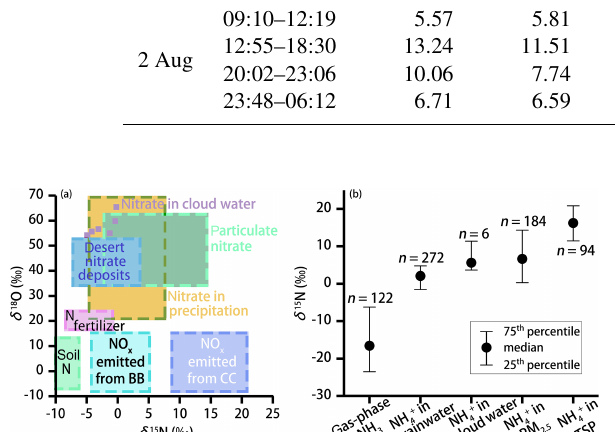
Figure 2. (a) Observed range of typical δ 18 O and δ 15 N values of NO − and NO x for different sources (adapted from Fenech et al., 3 2012). BB and CC represent biomass burning and coal combustion, respectively. The light purple squares represent nitrate isotope data in cloud water (this study). (b) The 25th percentiles, median, and 75th percentiles for the δ 15 N values of the ambient NH 3 (Chang et al., 2016; Felix et al., 2013; Savard et al., 2018; Smirnoff et al., 2012) and NH + in precipitation (Fang et al., 2011; Leng et 4 al., 2018; Yang et al., 2014; Zhang et al., 2008), cloud water (this study), PM 2 . 5 (particulate matter with aerodynamic diameter less than 2.5µm; Lin et al., 2016; Park et al., 2018; Proemse et al., 2012; Smirnoff et al., 2012), and TSPs (total suspended particles with aerodynamic diameter less than 100µm (Kundu et al., 2010; Savard et al., 2018; Yeatman et al., 2001) are